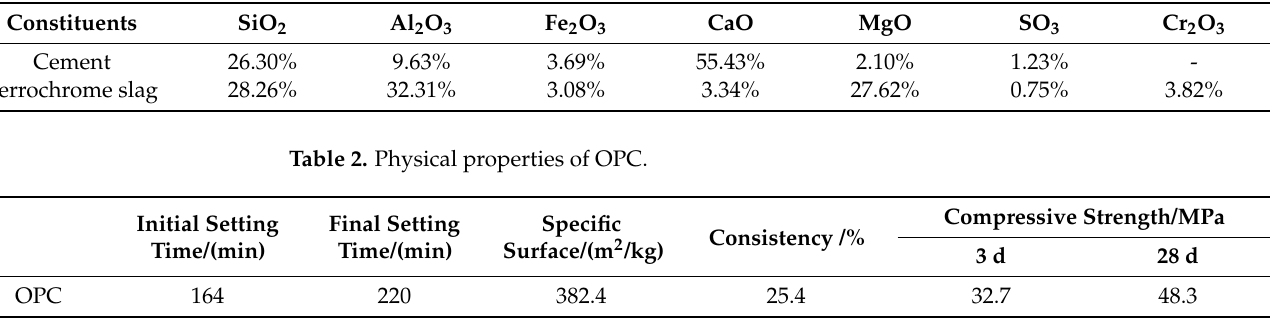
Table 1. Chemical constituents of cement and ferrochrome slag.